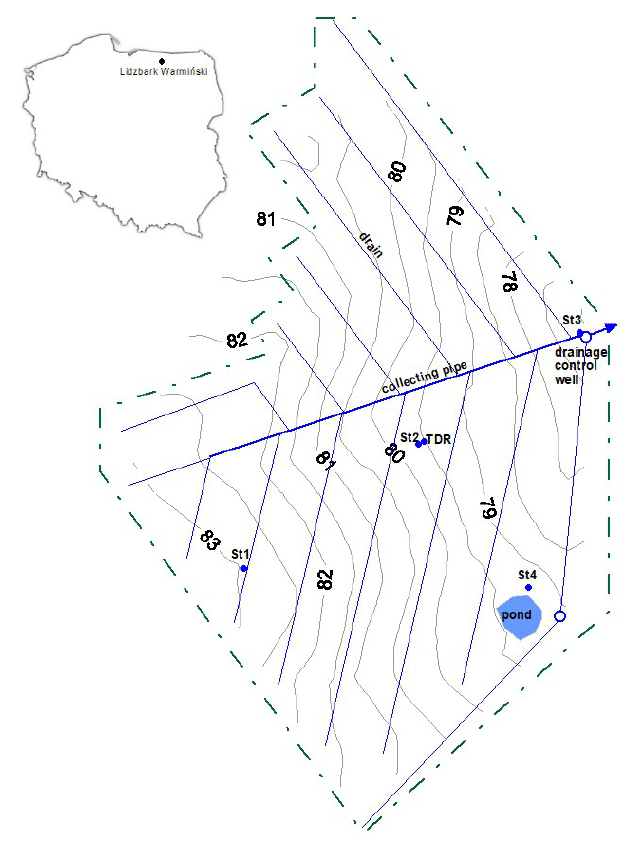
Figure 1. Visual location and scheme of the experimental site.